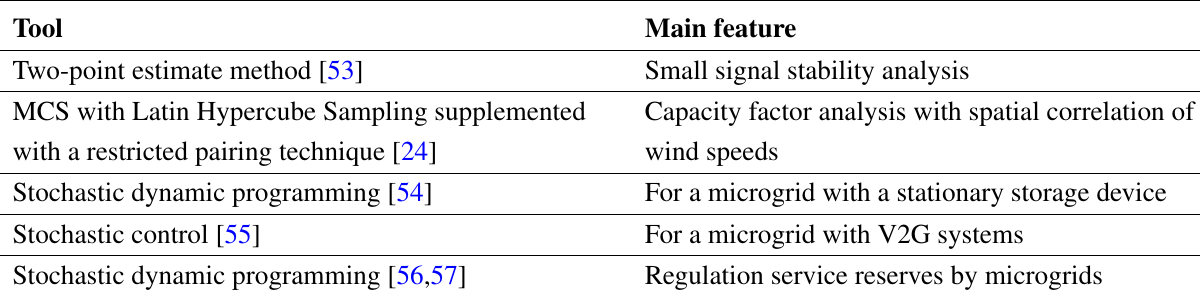
Table 5. Stochastic modeling and optimization tools for microgrid